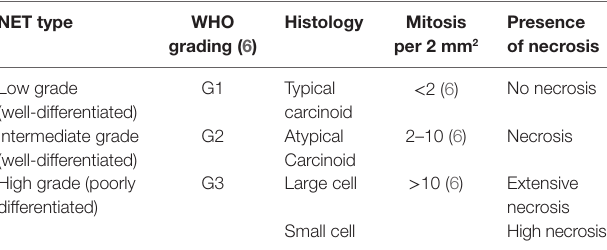
TABLe 1 | WHO Classification of neuroendocrine tumors